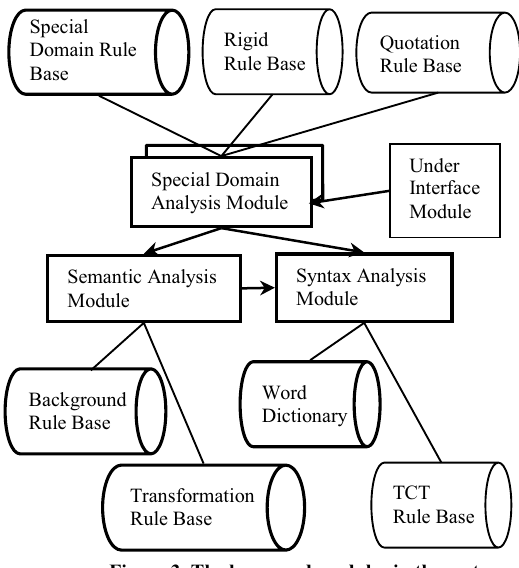
Figure 3 The bases and modules in the system In Figure 3, the thin line indicates the relation between the model and the bases and the thick line with arrow indicate the reference relation among the